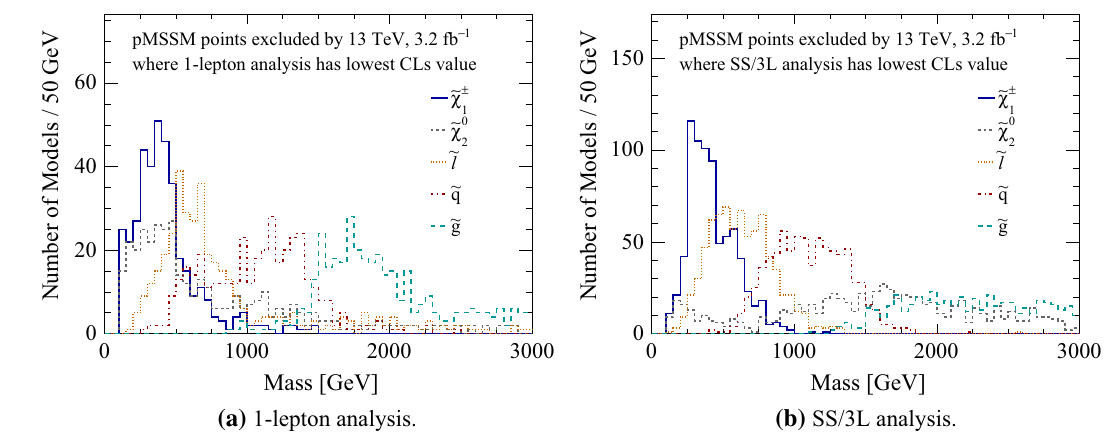
Fig. 5 Distribution of sparticle masses for the excluded points where ( grey short-dashed ), lightest slepton ˜ (cid:4) ( orange dotted ), light- tralino ˜ χ 0 2 the 1-lepton ( left ) and SS/3L ( right ) analyses are most sensitive. Pre- est squark ˜ q ( red dot-dashed ) and gluino ˜ g ( light blue long-dashed sented sparticles are the chargino ˜ χ ± ( blue solid ), next-to-lighest neu- 1